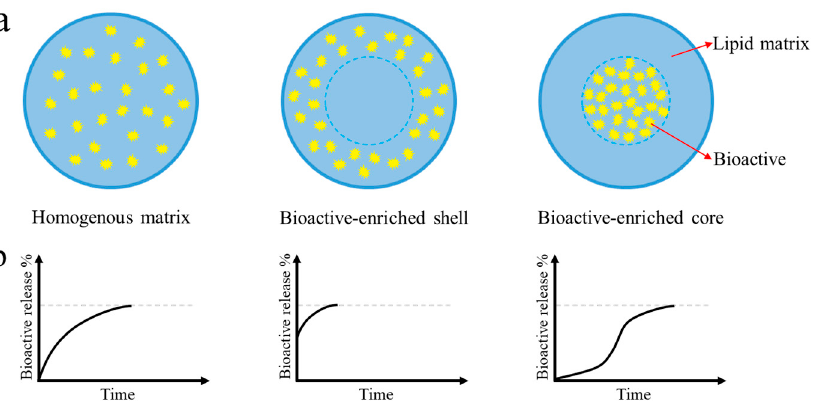
Figure 4. ( a ) Three models for the incorporation of bioactives into SLNs: homogenous matrix model (left), core-shell models with bioactive-enriched shell (middle), and bioactive-enriched core (right). ( b ) The release kinetics of bioactives from the SLNs with the corresponding three models (above).